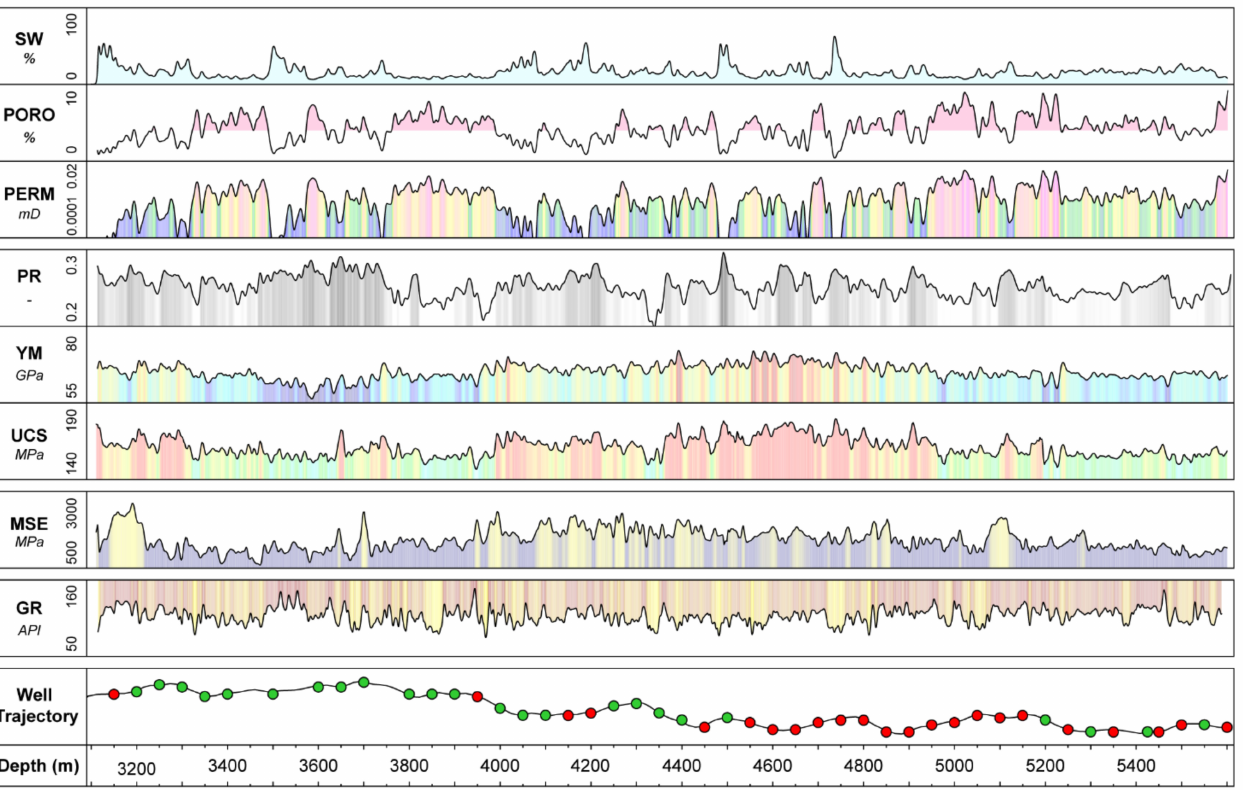
Figure 3. Petrophysical, geomechanical, and drilling derived properties calculated for the subject Montney well. The colored dots on the well trajectory track represent the location of the drill cutting